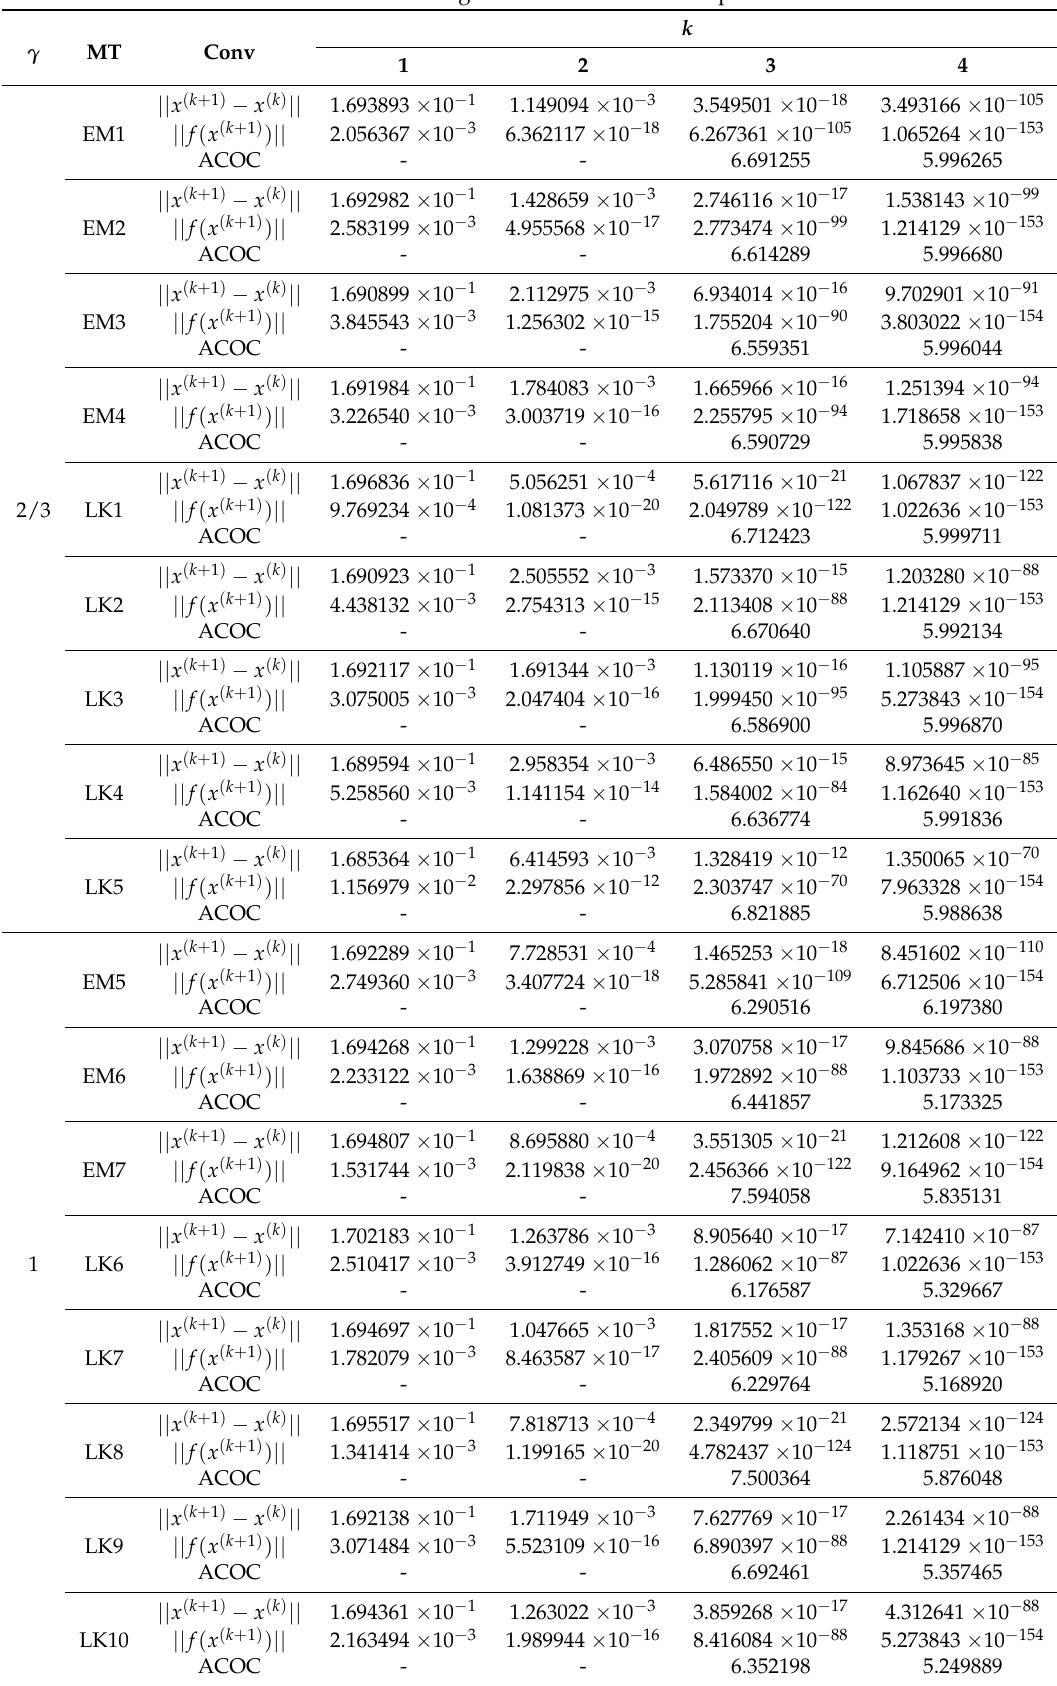
Table 6. Convergence results of Test Example